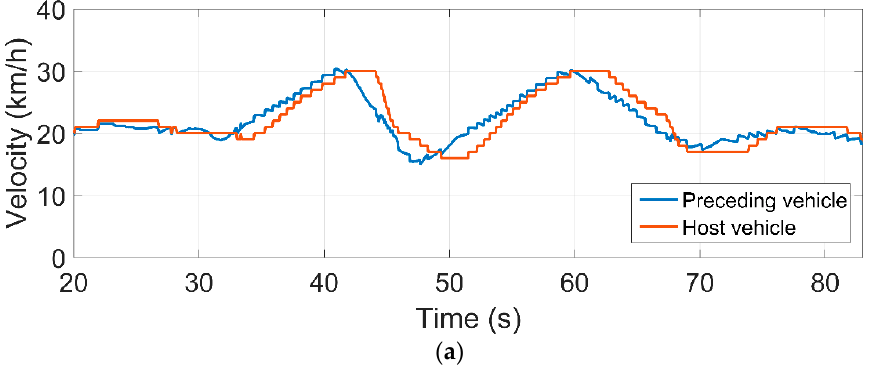
( b ) ( c ) Figure 12. Test results with a 1.2-s time headway: ( a ) velocity, ( b ) acceleration, and ( c ) distance. 5. Conclusions In this study, we propose an SRL-based framework for the longitudinal vehicle dynamics control of a CACC system. A supervisor trained by driving data from a human driver is introduced to guide the reinforcement learning process. During the learning process, the composite action of the supervisor network and the actor network is sent to the system, and the actor network is updated with the error provided by the supervisor and the critic network simultaneously. The gain scheduler adjusts the weighting between supervisor and actor to improve the learning efficiency and obtain a near-optimal control policy. The simulation results show that the performance of the proposed control strategy is superior to that of the linear controller, and the human driver’s acceleration characteristics can be successfully mimicked by the SRL-based strategy, resulting in an improving driver comfort and acceptance of the CACC system. In addition, the proposed framework is demonstrated on CACC test vehicles, and the effectiveness is validated by vehicle-following tests with satisfactory performance. Notably, the SRL algorithm can be implemented in a real-time way, such that the driver’s driving data are collected for online updating of the actor network to provide a human-like control policy. In the next step, the string stability for vehicle platooning will be considered in the SRL approach to reduce the impact of the trained control policy on traffic flow.